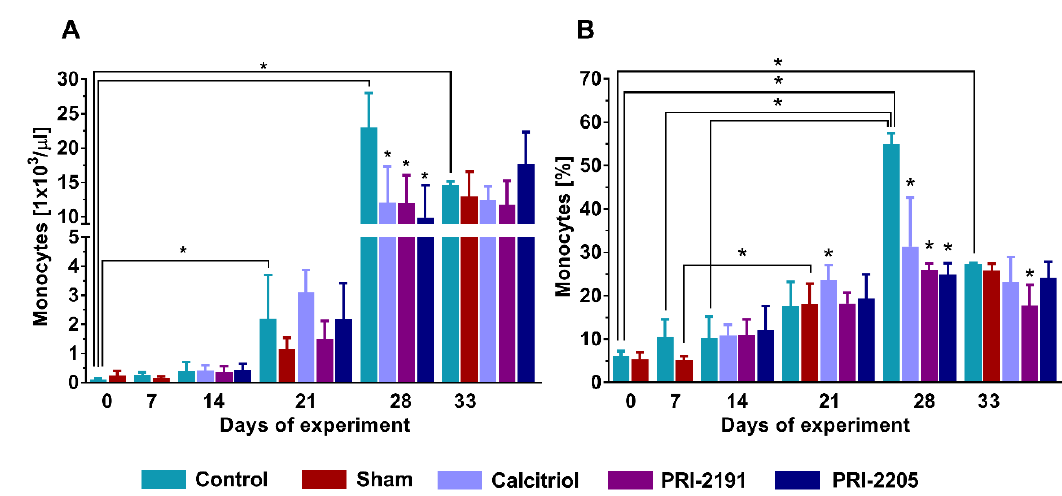
Figure 1. Whole blood monocytes measurement in 4T1 tumor-bearing aged OVX mice. ( A ) Total number of monocytes in whole blood. ( B ) Percentage of monocytes in whole blood among all leukocytes. Briefly, 60-week-old mice were subjected to ovariectomy or sham surgery. After 4 weeks, 4T1 cells were inoculated (day 0) orthotopically and subcutaneous administration of the tested compounds (three times a week) was initiated on day 7 at the following doses: calcitriol, 0.5 µg/kg; PRI-2191, 1.0 µg/kg; and PRI-2205, 10.0 µg/kg. The number of mice analyzed was 3–7 per group. Data presentation: ( A , B ), mean with standard deviation (SD). Statistical analysis: ( A , B ), Dunn’s multiple comparison test. * p < 0.05 as compared to control animals on the relevant day of treatment or as indicated.